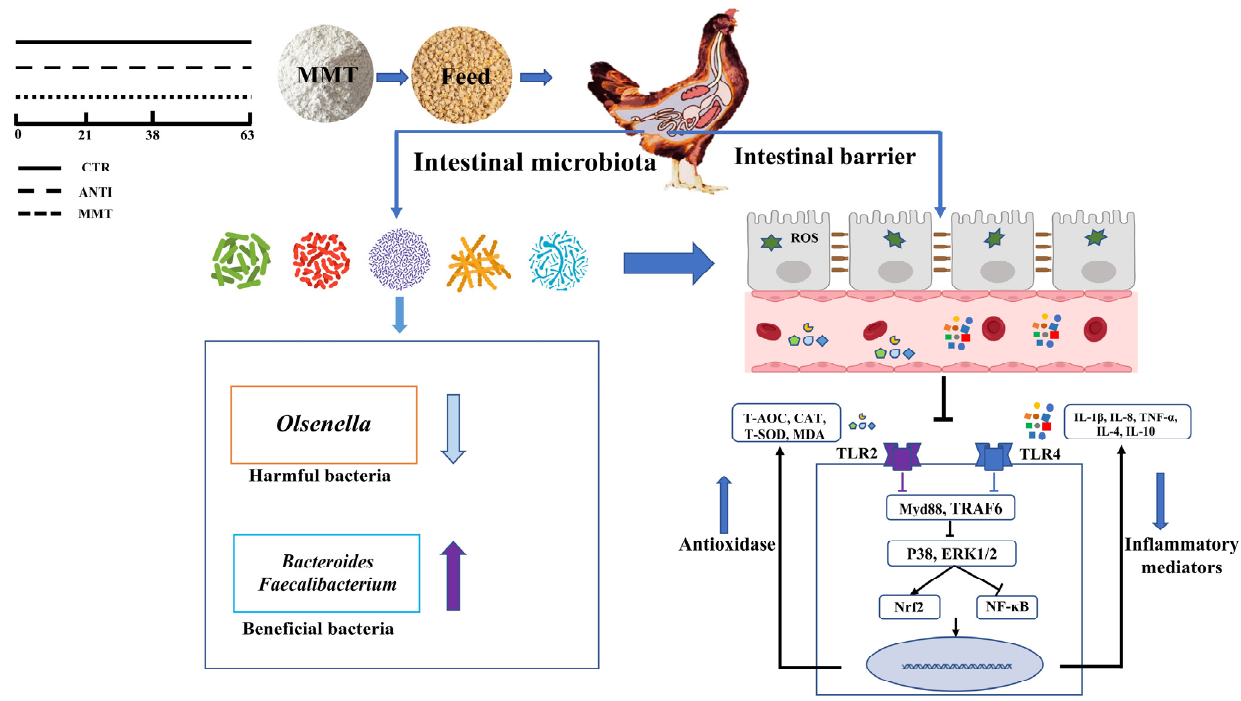
Figure 13. MMT supplementation improved the growth performance of broilers by modulating intestinal microbiota, enhancing the intestinal barrier function, and improving inflammatory response, which might be mediated by inhibiting the TLRs/MAPK/NF- κ B signaling pathway, and antioxidative capacity mediated by the Nrf2/HO-1 signaling pathway. ↑ Arrows indicate the effect of stimulation; ↓ Arrows indicate the effect of stimulation; ┬ Arrows indicate the effect of suppression.